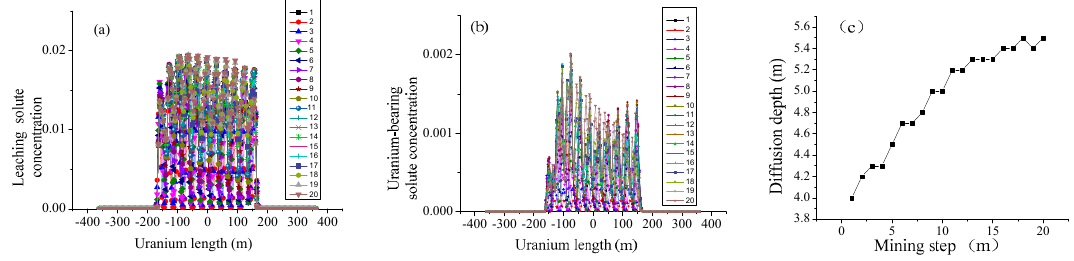
Figure 5. Reactive solute transport and distribution. ( a ) Distribution of the leaching solution; ( b ) Distribution of the uranium-bearing solution; ( c ) Uranium-bearing solution transport.